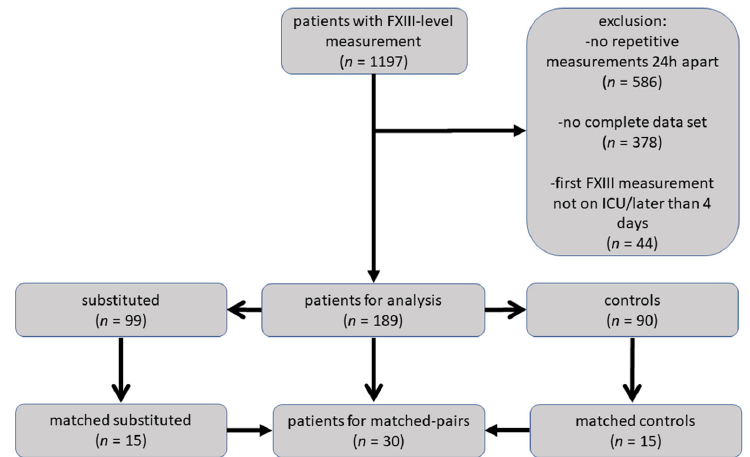
Figure 1. Flowchart depicting patient selection and enrollment according to predefined criteria. All patients were retrospectively recruited for the study. FXIII, coagulation factor XIII; ICU, intensive care unit.